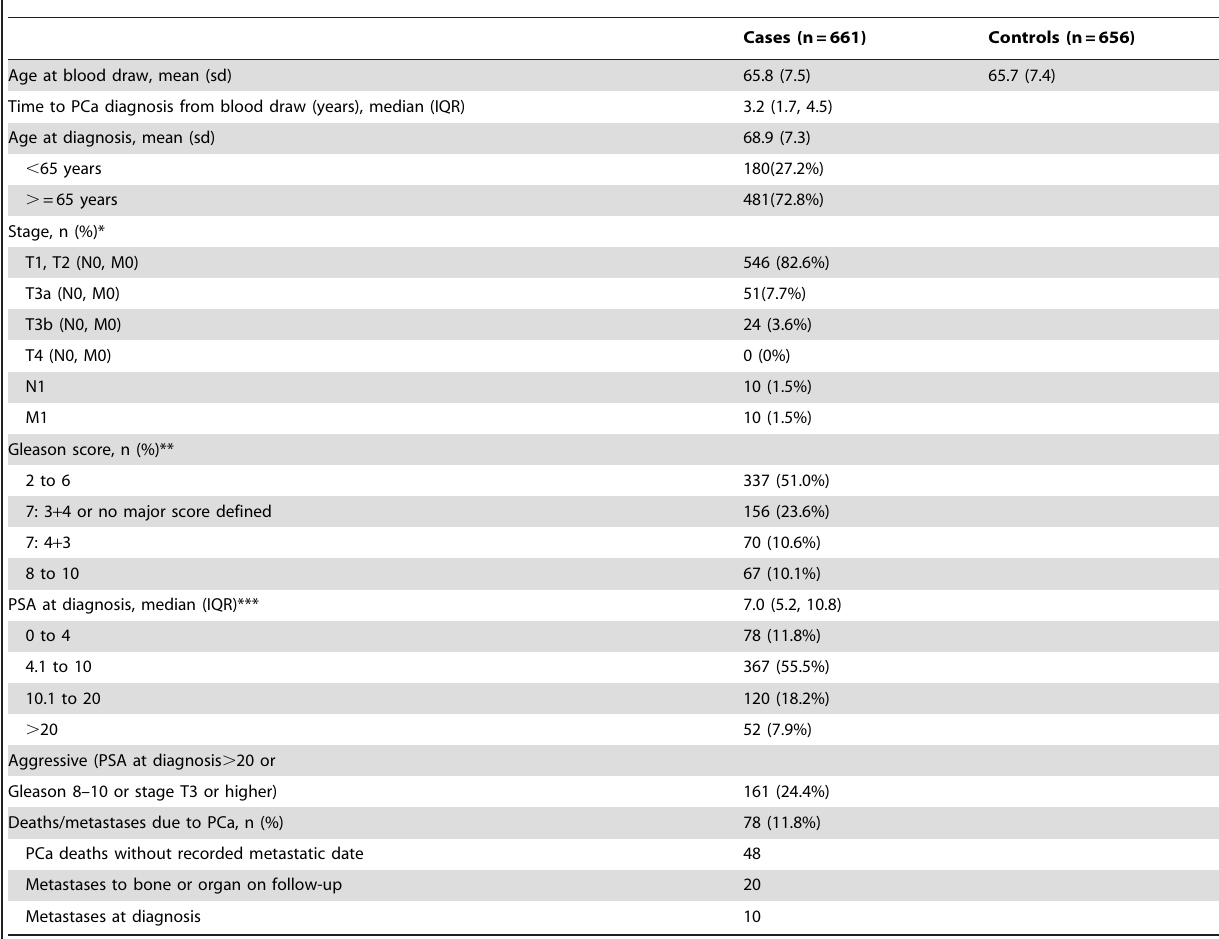
Table 1. Characteristics of prostate cases (PCa) and